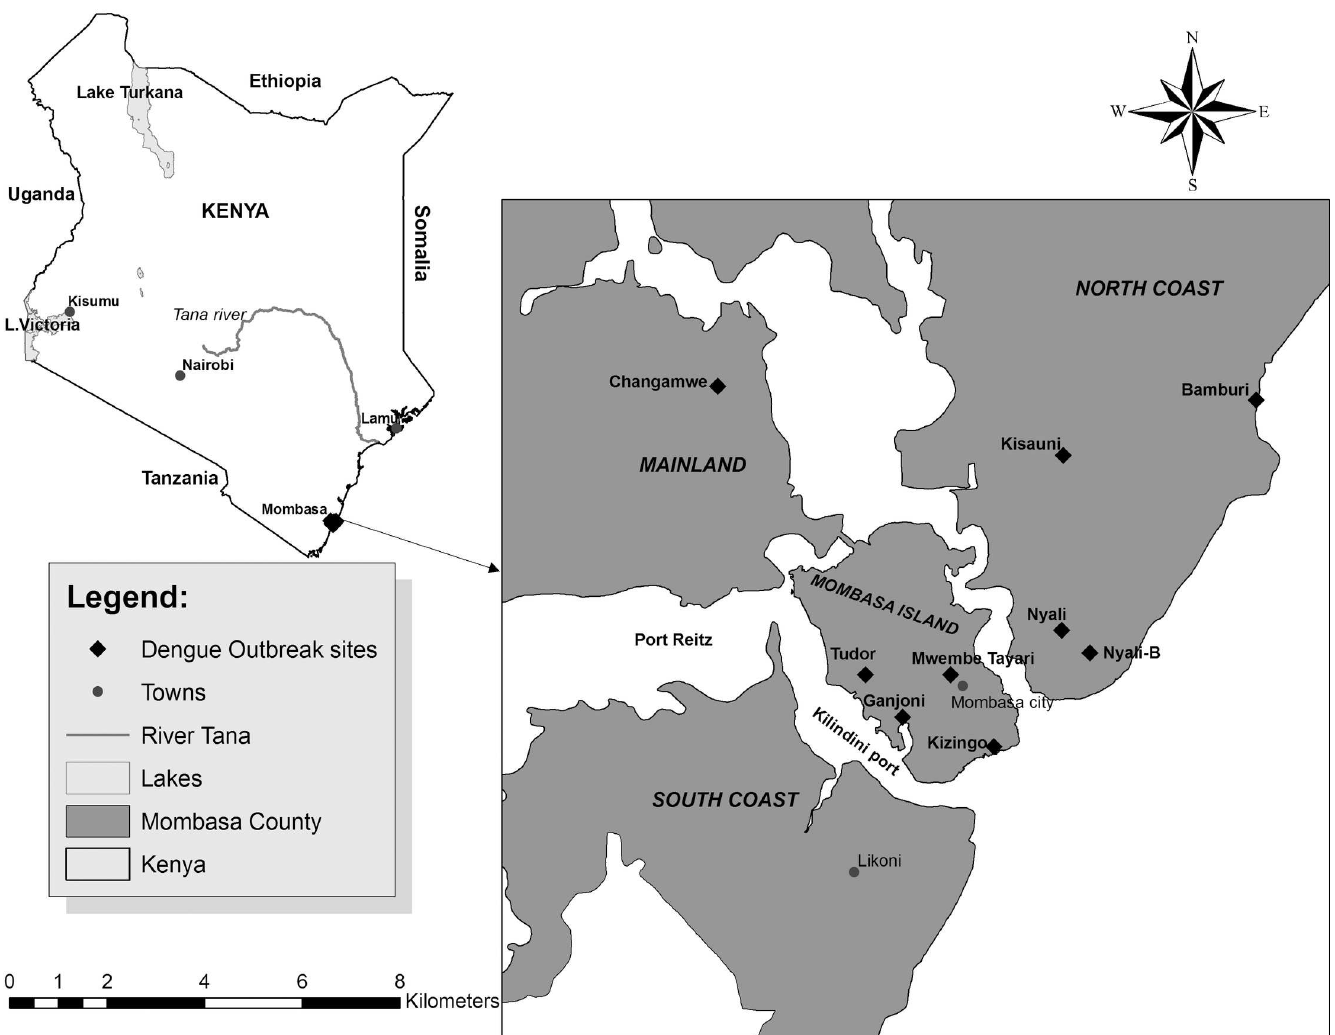
Fig 1. The overall map of Kenya and Mombasa city showing the dengue outbreak sites where vector sampling was